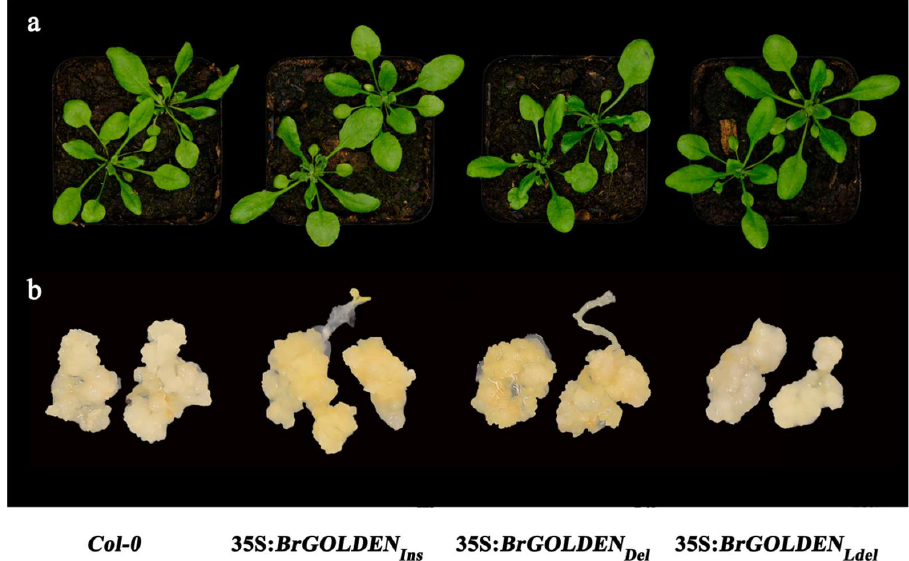
Figure 9. Phenotypic observations of plants and seed − derived calluses of A. thaliana lines overexpressing BrGOLDEN lines. ( a ) Rosette stage phenotypes of 35 S: BrGOLDEN transgenic and wild − type A. thaliana seedlings at four weeks. ( b ) Representative images from seed − derived calluses of BrGOLDEN overexpressing lines and the wild type.